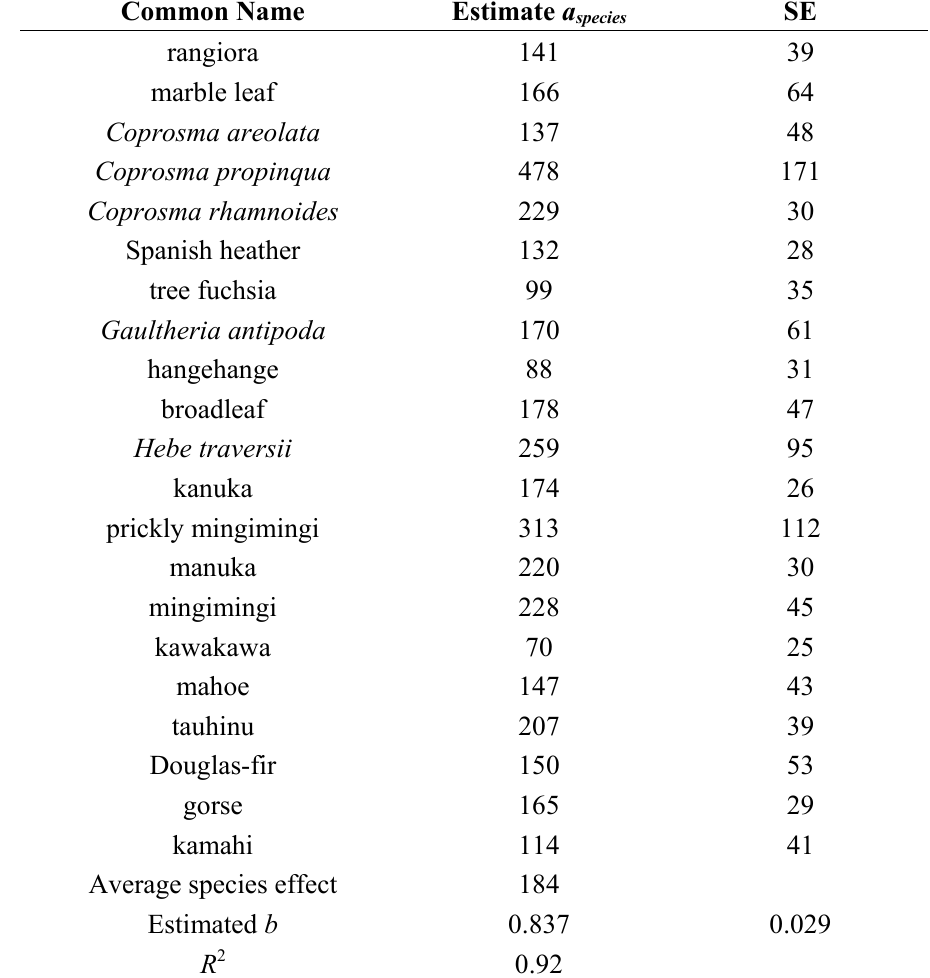
Table 1. Coefficients ( a species , b ) of the allometric model for estimating dry weight (kg) of each tree or shrub from the summed basal area of stems (m 2 ) measured 10 cm above ground level and height (m) using the equation: DryWeight = a species ( BA × Height ) b . Model coefficients were obtained using the SAS GLIMMIX procedure, while the R 2 value is reported for the log-log